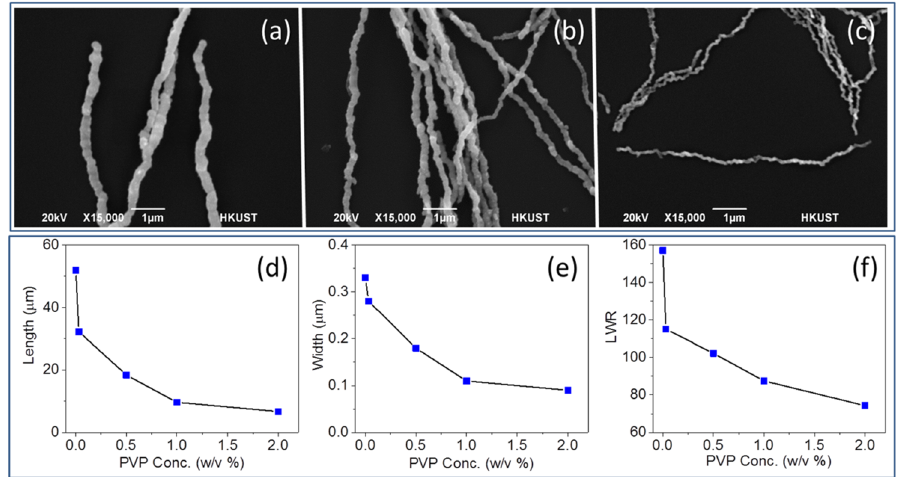
Figure 4. SEM images with same magnification of NiNWs synthesized with poly(vinylpyrrolidone) (PVP) concentration of ( a ) 0.03 w / v %, ( b ) 0.5 w / v %, and ( c ) 2 w / v %. The change of ( d ) length, ( e ) width, and ( f ) LWR of NiNWs with PVP concentration.